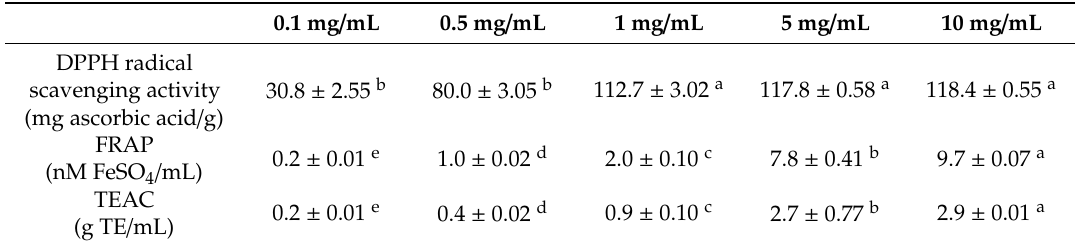
Table 3. DPPH radical scavenging activity, FRAP, and TEAC of A. koraiensis ethanol extracts (AKE).